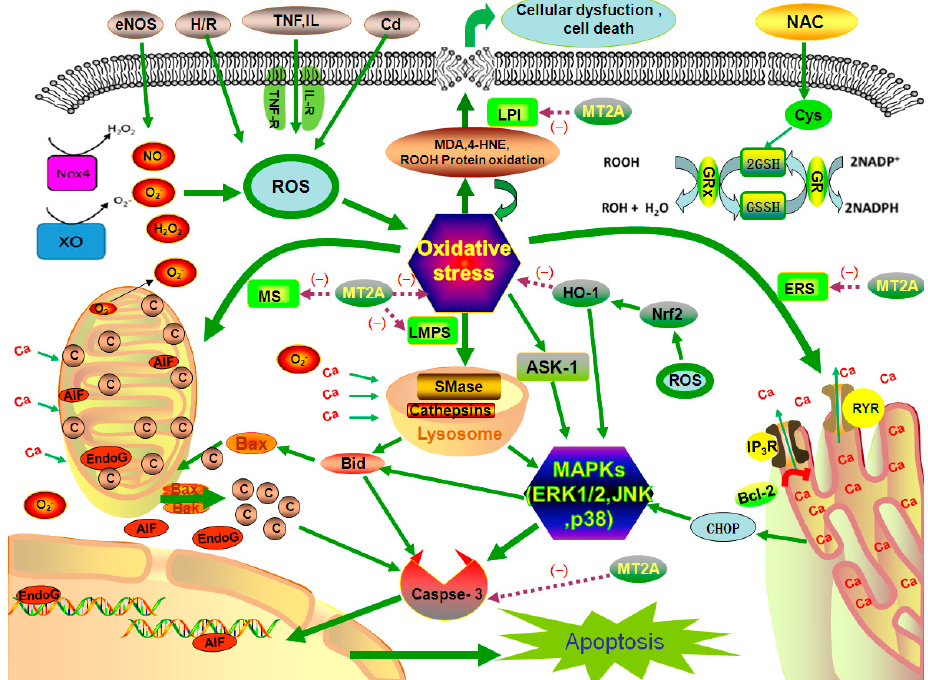
Figure 2. Interactions of subcellular structure during oxidative stress and activation cell apoptosis pathway through mitogen-activated protein kinases (MAPKs). Mammalian metallothionein-2A (MT2A) might inhibit oxidative stress through four subcellular structures. Mitochondrial Stress—MS, Endoplasmic Reticulum Stress—ERS, Lysosomal Membrane Permeabilization Stress—LMPS, Lipid Peroxidation Injury—LPI, Endothelial Nitric Oxide Synthase—eNOS: (green arrows : caused definitely, brown dotted arrows : caused indefinitely, Inhibit( － )).